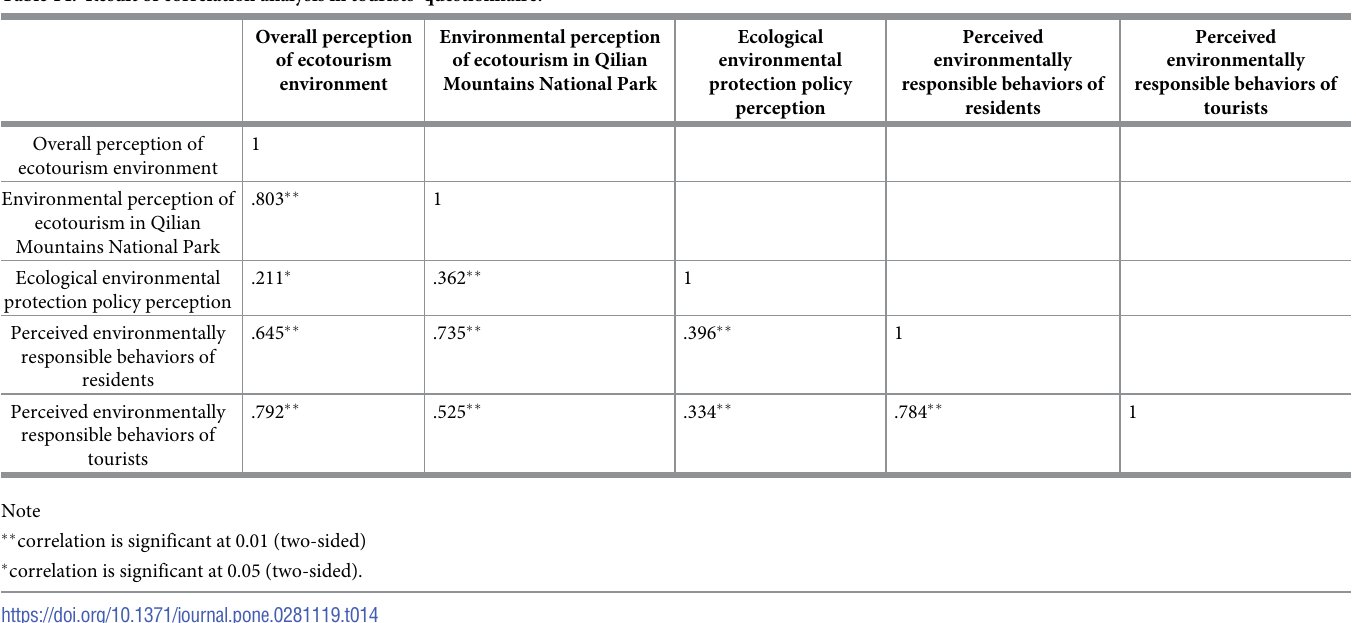
Table 14. Result of correlation analysis in tourists’ questionnaire.